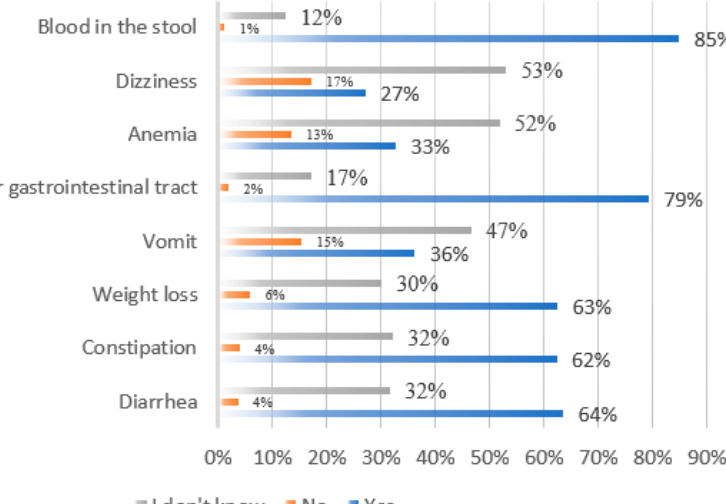
Figure 1. Knowledge of symptoms of colorectal cancer in the studied population of students from the Silesian province. Source: own study.